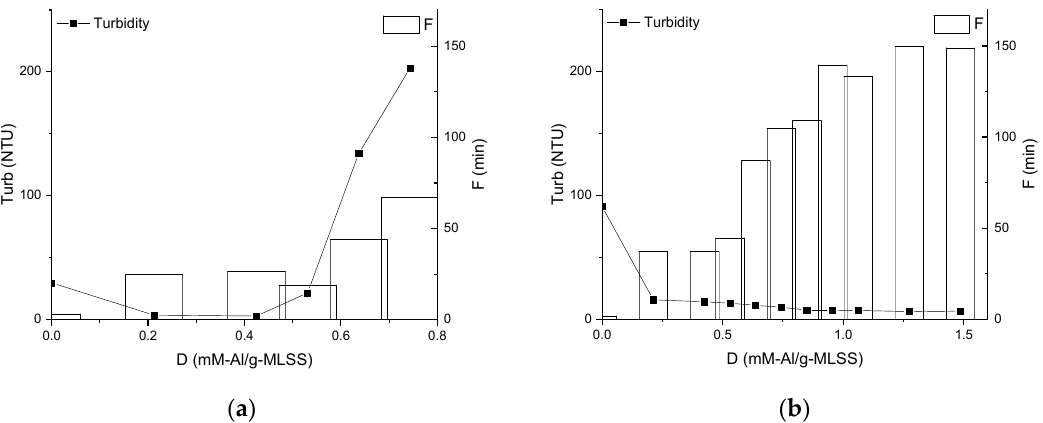
Figure 6. Influence of chemical enhancer dose on supernatant turbidity and filtration duration of Mixed Liquors from MBBR ( a ) and IFAS ( b ).